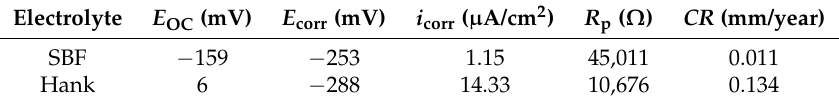
Table 1. The electrochemical parameters of Ti25Nb10Zr alloy after tests in simulated body fluid (SBF) and Hank solutions ( E OCP —open circuit potential; R p —polarization resistance; E corr —corrosion potential at i = 0; i corr —corrosion current density; CR —corrosion rate). The E OCP values were the last measured values in Figure